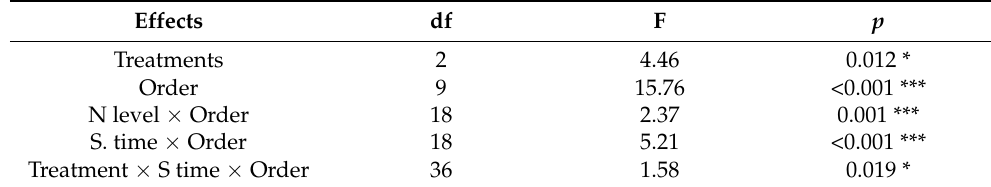
T = treatments and S = sampling time. Numbers in the table not sharing the same letter differ sig-